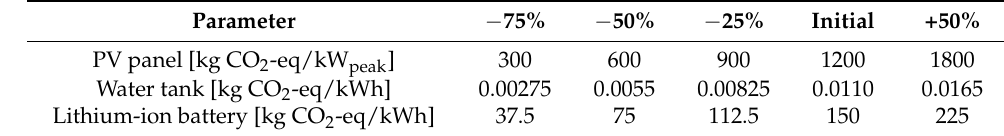
Table 7. Parameters for assessing the effects of varying component life cycle emission